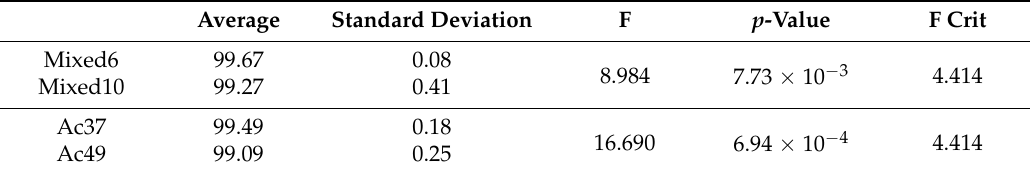
Table 6. One-way analysis of variance (ANOVA) with α =